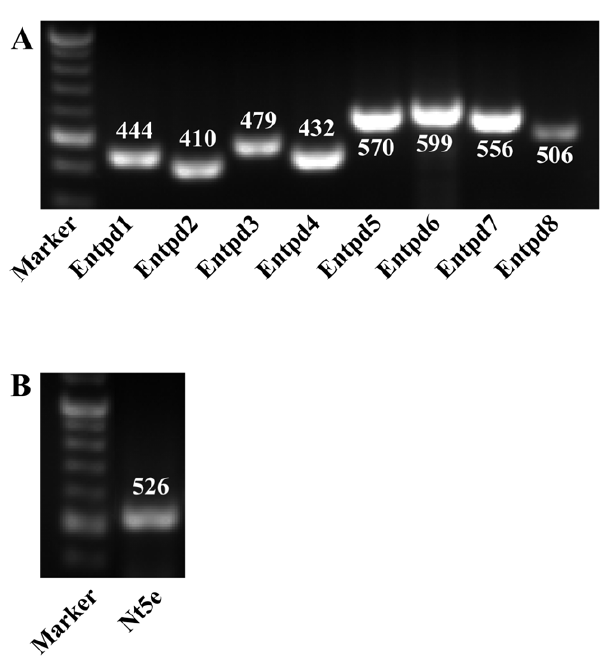
Figure 1. Expression of ectonucleotidases in mouse bladder by RT-PCR. Expression of ectonucleotidases was detected by RT-PCR from total RNA isolated from mouse bladder. Specific primers for each enzyme are given in Table 1. RT-PCR reaction products were resolved on 2% agrose gels and visualized by staining with ethidium bromide. Numbers above or beneath the DNA bands are expected product sizes (in bp). A) ENTPD family, B) NT5E.